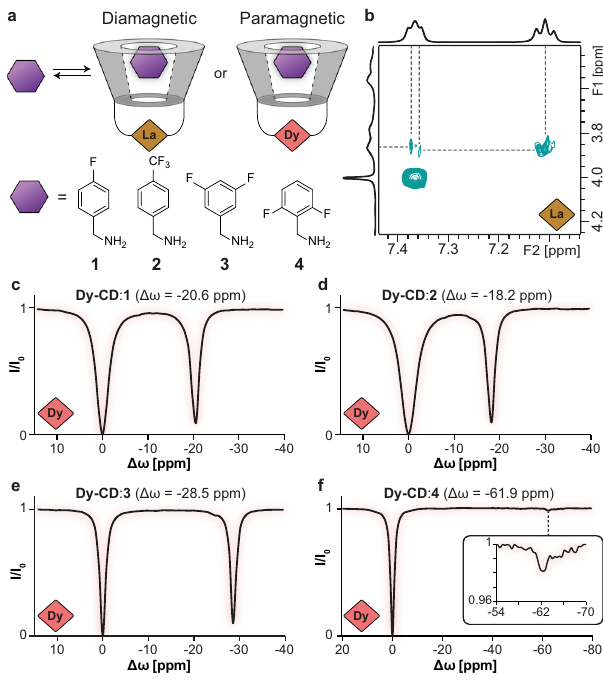
Fig. 2 Paramagnetic guest exchange saturation transfer (paraGEST) nuclear magnetic resonance (NMR) of variable guests. a Schematic illustration of the diamagnetic lanthanum-cyclodextrin ( La-CD , brown diamond) and paramagnetic dysprosium-cyclodextrin ( Dy-CD , peach diamond) hosts and guests 1 – 4 (represented by a purple hexagon) used to determine guest inclusion and paraGEST characteristics. b A section of the proton – proton rotating frame overhauser effect spectroscopy ( 1 H – 1 H ROESY) spectrum acquired from an aqueous solution of 1 and La - CD . The z-spectra obtained from aqueous solutions containing the paramagnetic host Dy-CD and guests 1 ( c ), 2 ( d ), 3 ( e ), and 4 ( f , inset shows magni fi cation of the paraGEST effect at − 61.9